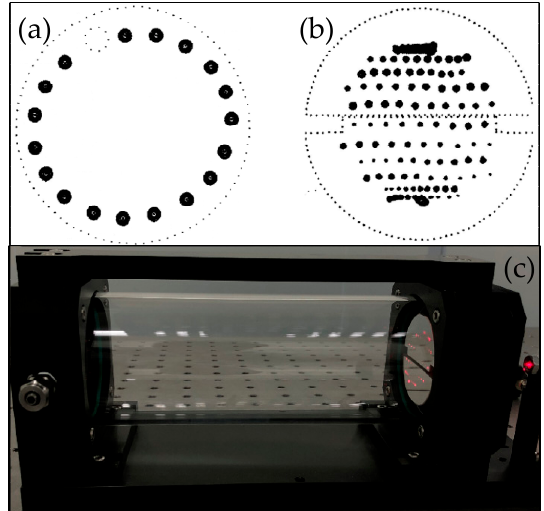
Figure 5. ( a ) Mirror spots of the conventional optical chamber distributed in a circular shape. ( b ) Mirror spots of a multi-reflection chamber distributed in 13 rows. ( c ) Photo of the multi-reflection chamber.